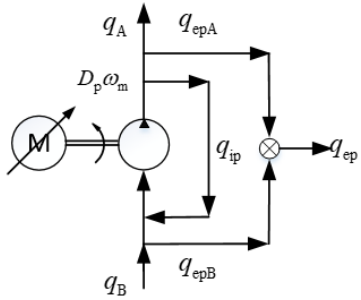
Figure 2. Flow distribution of hydraulic pump.